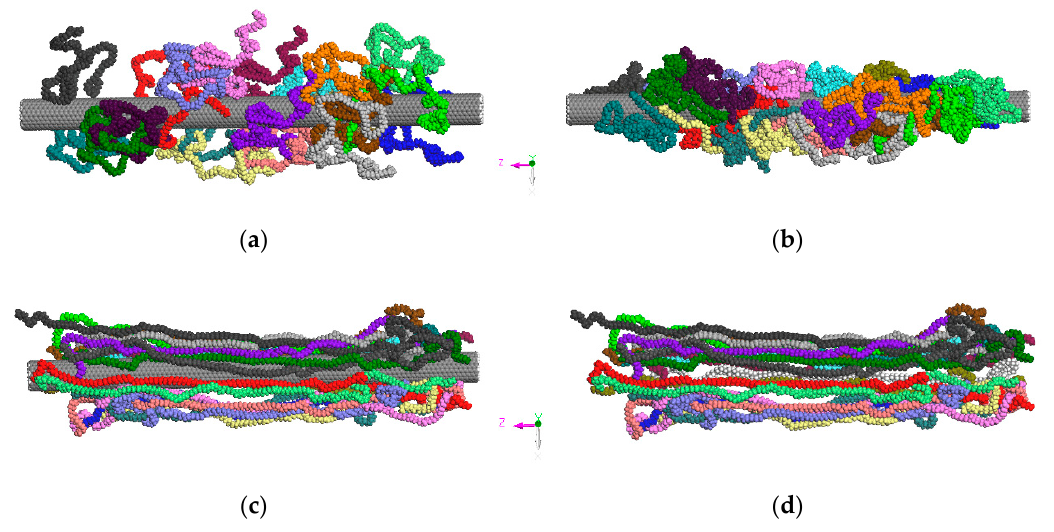
Figure 1. Simulation models. ( a ) Initial model of composite system; ( b ) Initial conformation of composite system under static conditions; ( c ) Initial conformation of the composite system after shear; ( d ) Initial conformation of pure polyethylene (PE) system after shear.